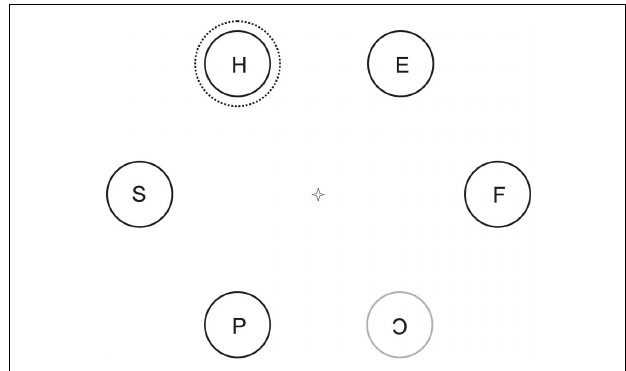
FIGURE 1 |A possible incongruent experimental trial after target and distractor presentation. The five black circles represent non-targets that have just changed color from gray to orange.The single gray circle did not change color and forms the target.The dashed circle appears simultaneously with the target and forms the distractor.The distractor can be either superluminant or equiluminant to all other stimuli. In this trial subjects should make a saccade to the bottom right circle and respond with the left